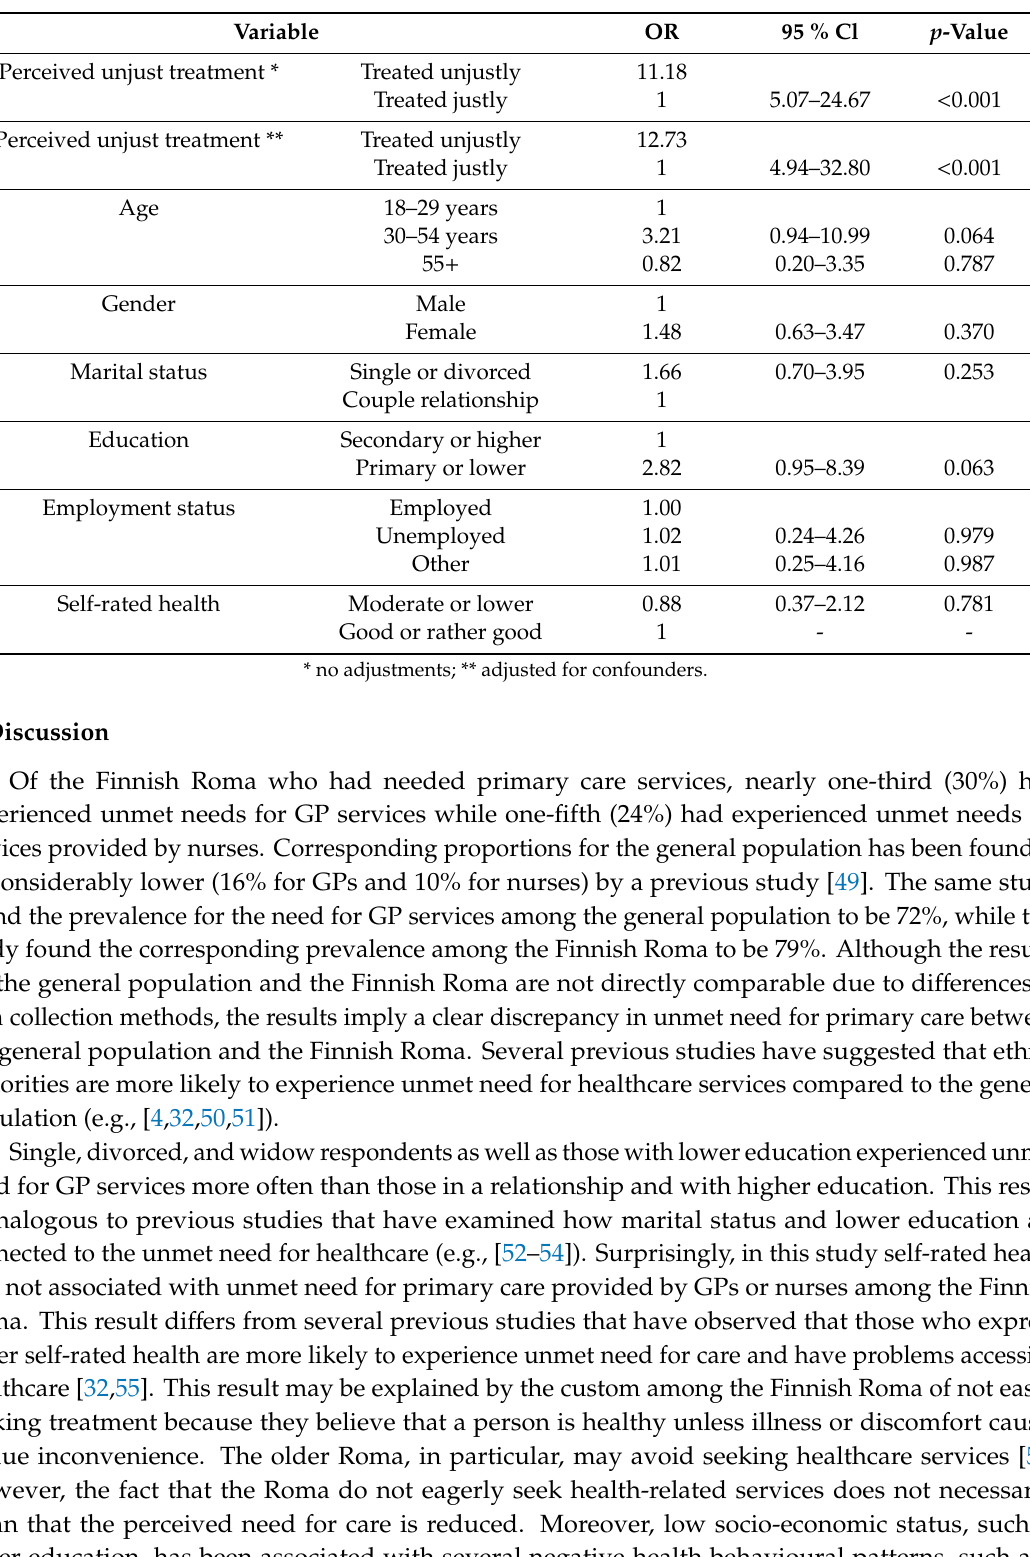
Table 4. The association between perceived unjust treatment and unmet need for nurses, %, 95% CI and p -value. The results adjusted for age, gender, marital status, education, employment status, and self-rated health **.